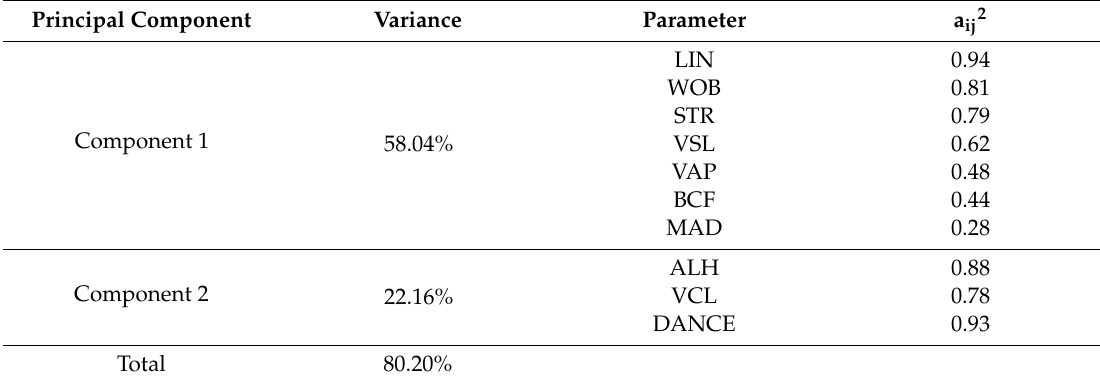
Table 1. Principal component analyses (PCA) based on individual kinematic parameters of all sperm cells evaluated by computer-assisted sperm analysis (CASA) system. As a result, two PCA components were obtained.